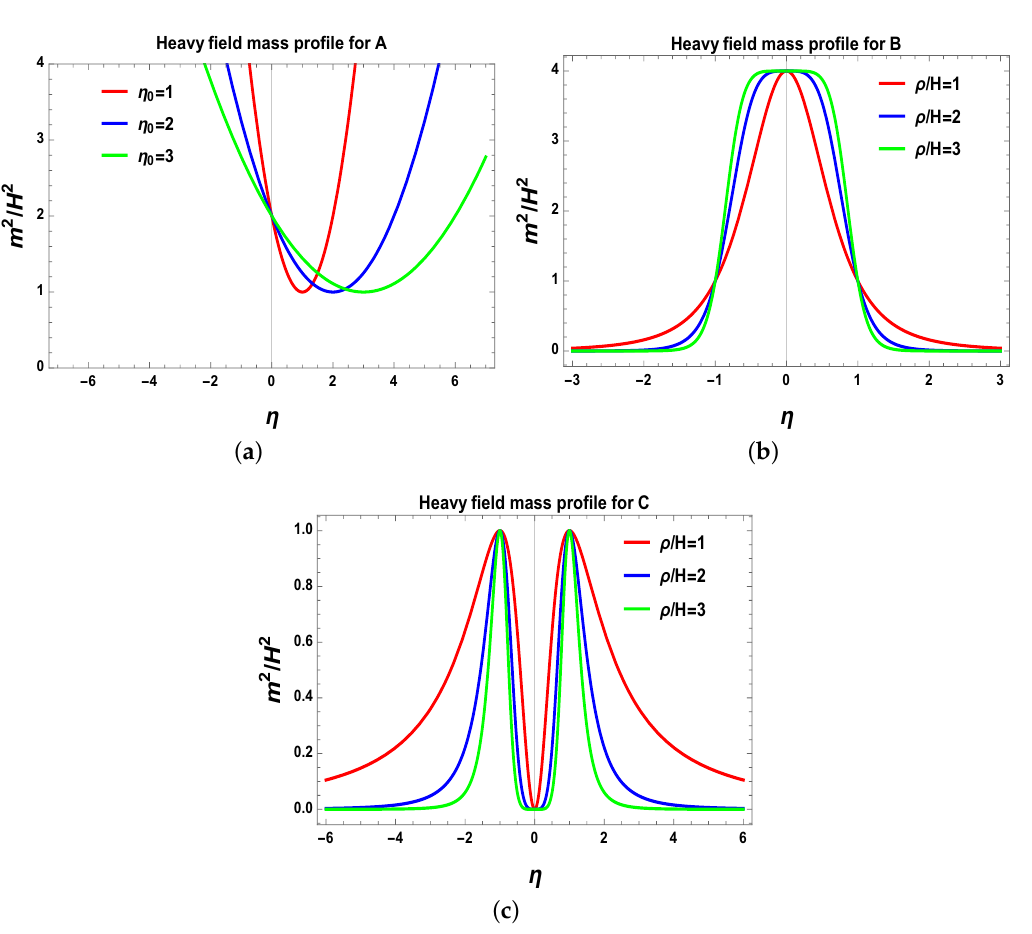
Figure 3. Toy model mass profiles for massive particles. ( a ) Mass profile for A with γ = 1 and δ = 1; ( b ) 2 = 1; ( c ) Mass profile for C with m 2 0 Mass profile for B with m 0 2 H 2